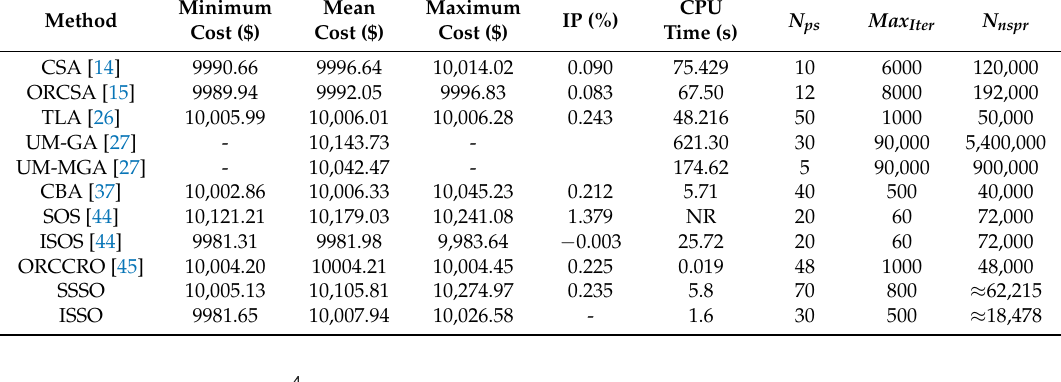
Table 8. Result summary obtained by different methods and the proposed method for system 5. Method